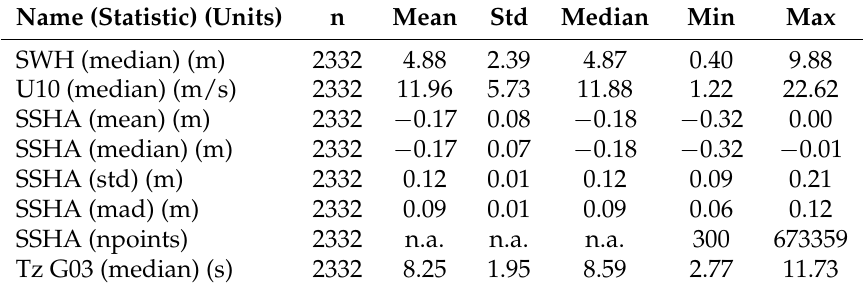
Table 2. Binning summary statistics with all parameters and metrics considered per bin. 2332 bins were validated to estimate a training dataset considering the first 3 years of Jason-1 mission. Bins with less than 300 measurements were discarded.